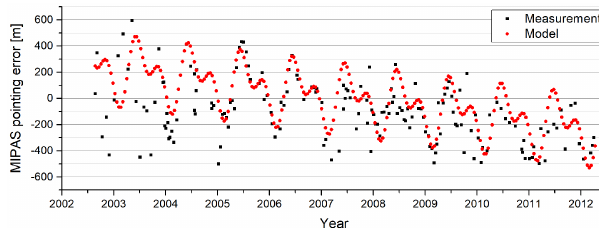
Figure 17. MIPAS pointing errors along the mission (grey) and fit- ted error model